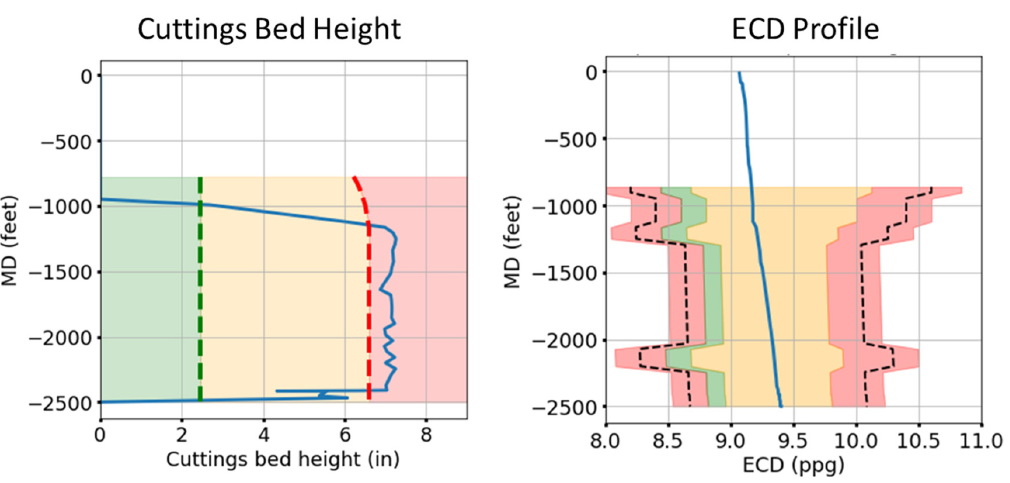
Figure 16. State of the borehole at the end of the circulation cycle.